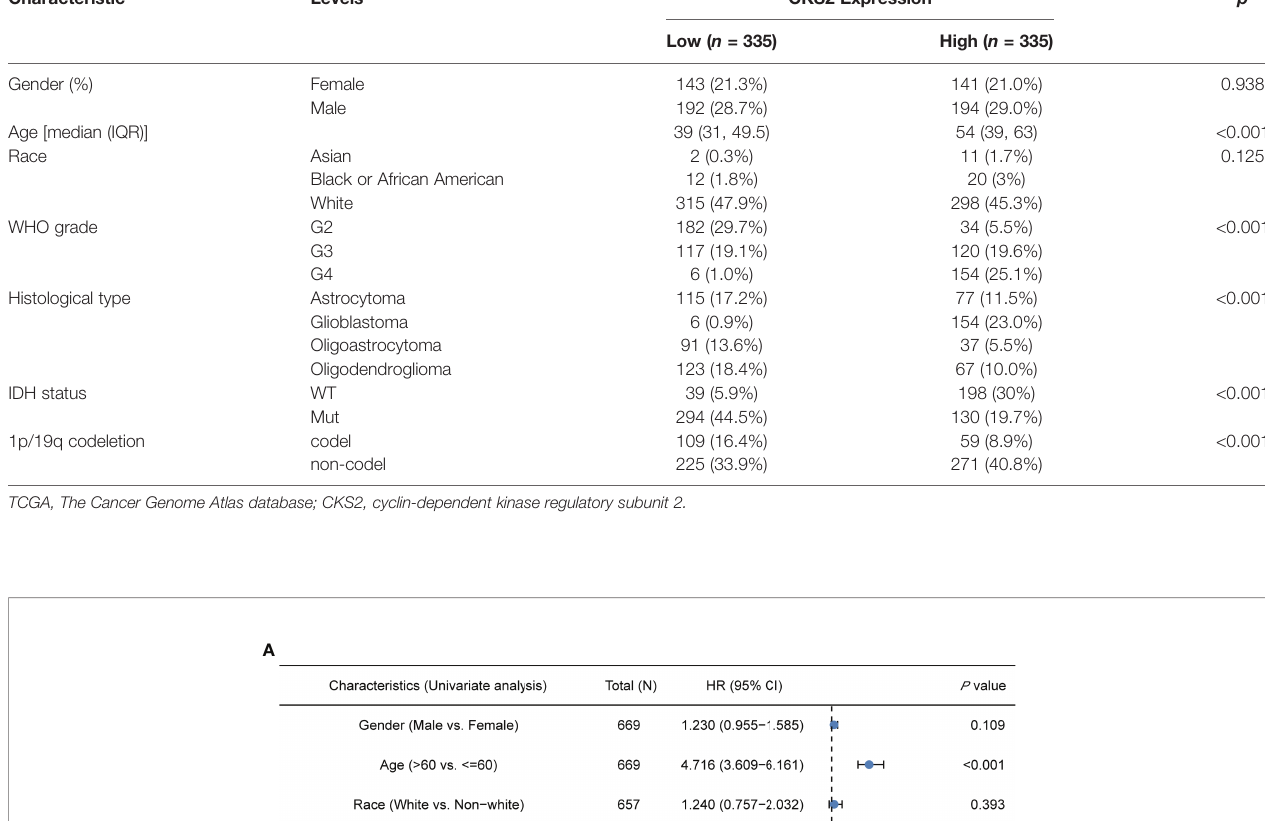
TABLE 1 | Demographic and clinical characteristics of patients with glioma with low and high expression of CKS2 in TCGA (n = 670). Characteristic